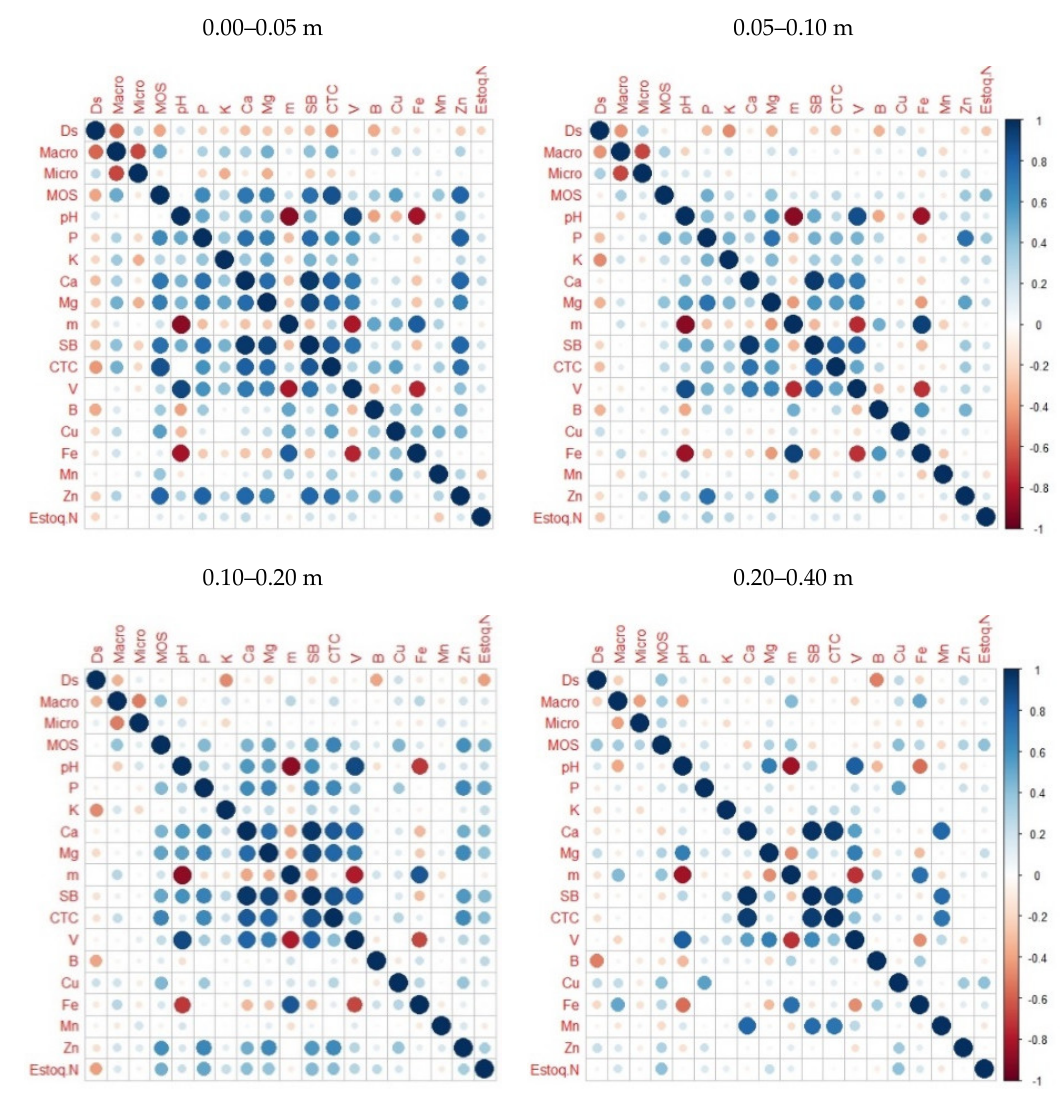
Figure 4. Pearson correlation matrix used to select the variables to be used in the Random Forest model to predict the soil carbon stock in different land use systems. Bd-bulk density (kg dm −3 ), Macro-macroporosity (m 3 m −3 ), Micro— microporosity (m 3 m −3 ), SOM—soil organic matter (g dm −3 ), pH—potential hydrogen, P—available phosphorus content (mg dm −3 ), K—potassium content (mmol c dm −3 ), Ca—calcium content (mmol c dm −3 ), Mg—magnesium content (mmol c dm −3 ), m—saturation by aluminum (mmol c dm −3 ), SB—sum of bases (mmol c dm −3 ), CEC—cation-exchange capacity (mmol c dm −3 ), V—bases saturation (%), B—Boron content (mg dm −3 ), Cu—copper content (mg dm −3 ), Fe—iron content (mg dm −3 ), Mn—manganese content (mg dm − 3 ), Zn—zinc content (mg dm − 3 ), and N Stock—nitrogen stock (Mg ha − 1